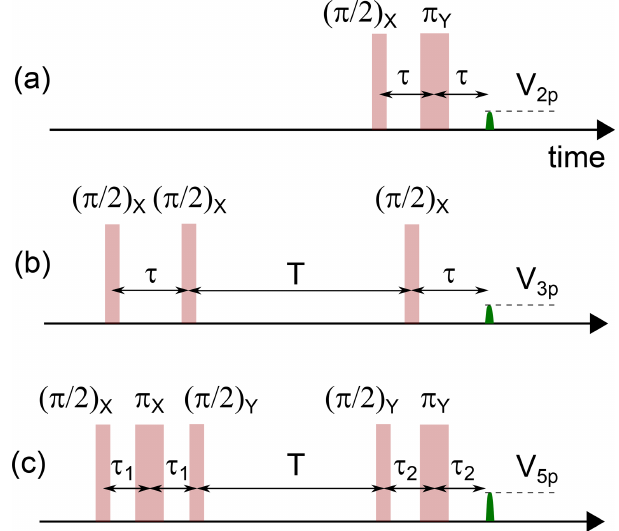
Figure 1. Sequences used for two-pulse (a) , three-pulse (b) , and five-pulse (c) ESEEM